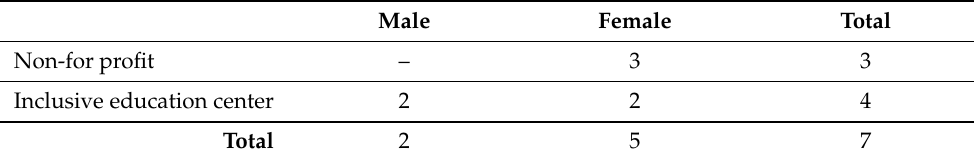
Table 8. Participant summary of Max